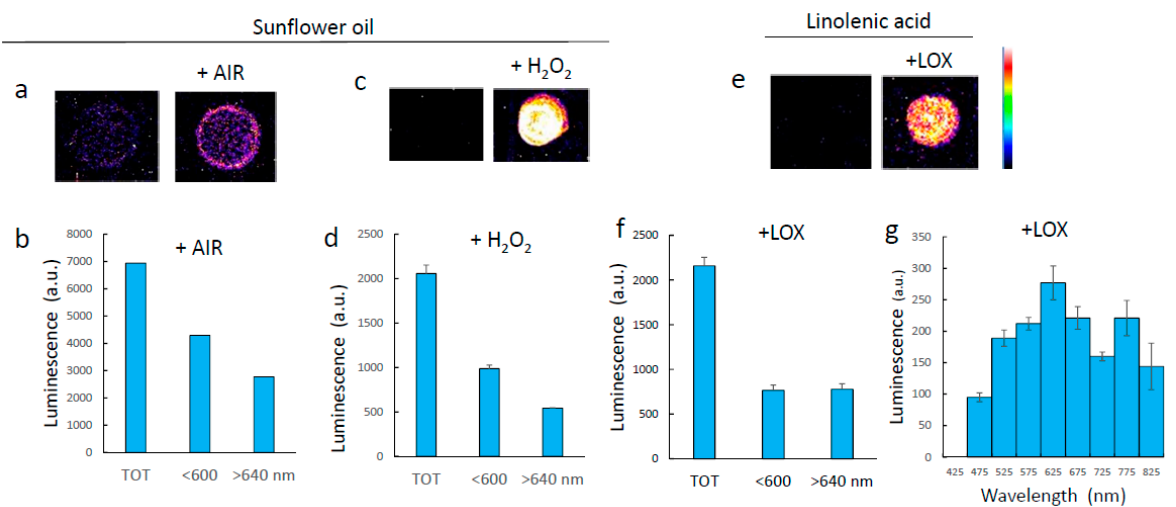
Figure 3. Luminescence imaging of lipids oxidized in vitro. ( a ) Luminescence image of sunflower oil oxidized by aeration under stirring. ( b ) Luminescence intensity of aerated sunflower oil at wavelengths <600 nm and >640 nm. ( c ) Luminescence image of sunflower oil oxidized by hydrogen peroxide in the presence of iron. ( d ) Luminescence intensity of hydrogen peroxide-treated sunflower oil at wavelengths <600 nm and >640 nm. ( e ) Luminescence image of linolenic acid oxidized by soybean LOX. ( f ) Luminescence intensity of oxidized linolenic at wavelengths <600 nm and >640 nm. ( g ) Luminescence spectrum of oxidized linolenic acid. TOT = total signal intensity.